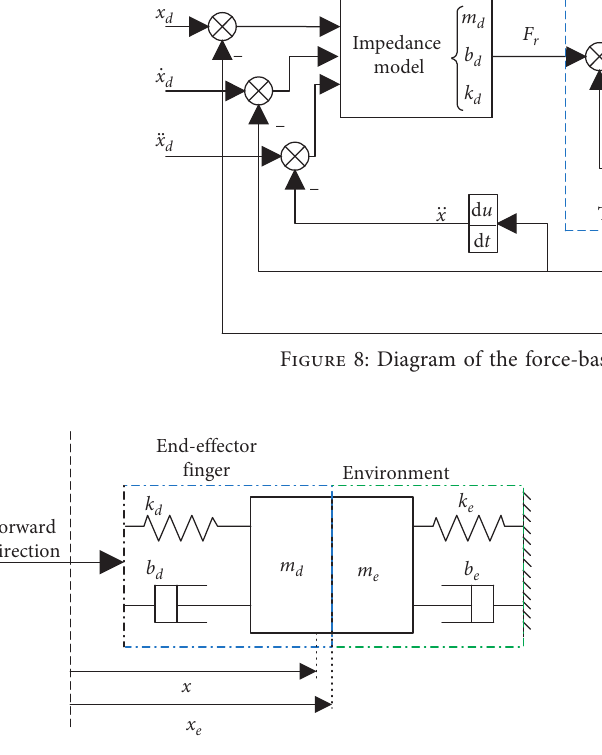
Figure 9: Model of grasping